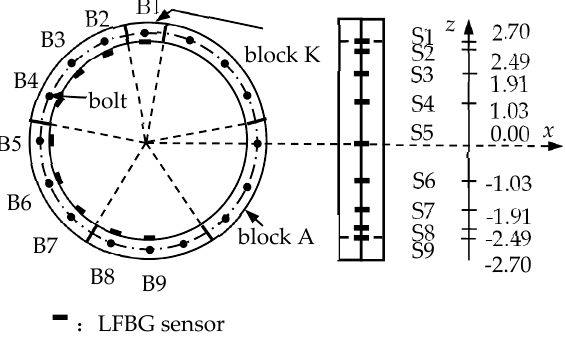
Figure 8. The LFBG sensor placement in one segment (Unit: m).